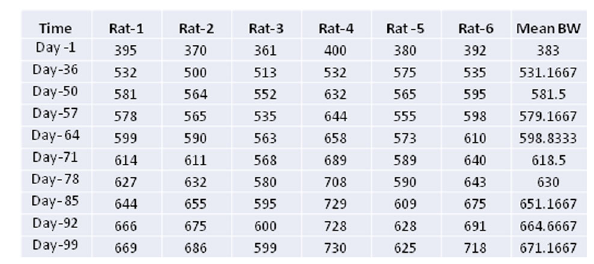
Table 1 Rat body weight during the experiment